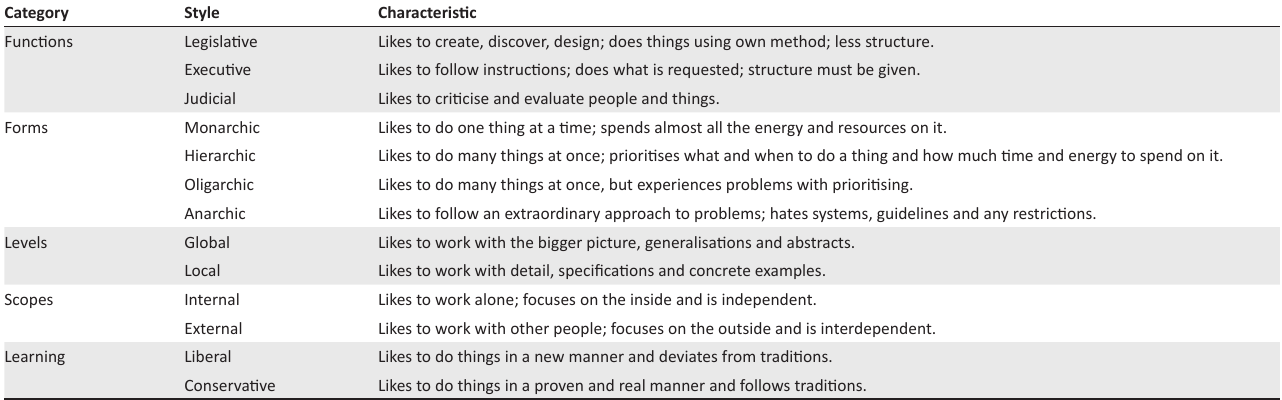
TABLE 1: Thinking style